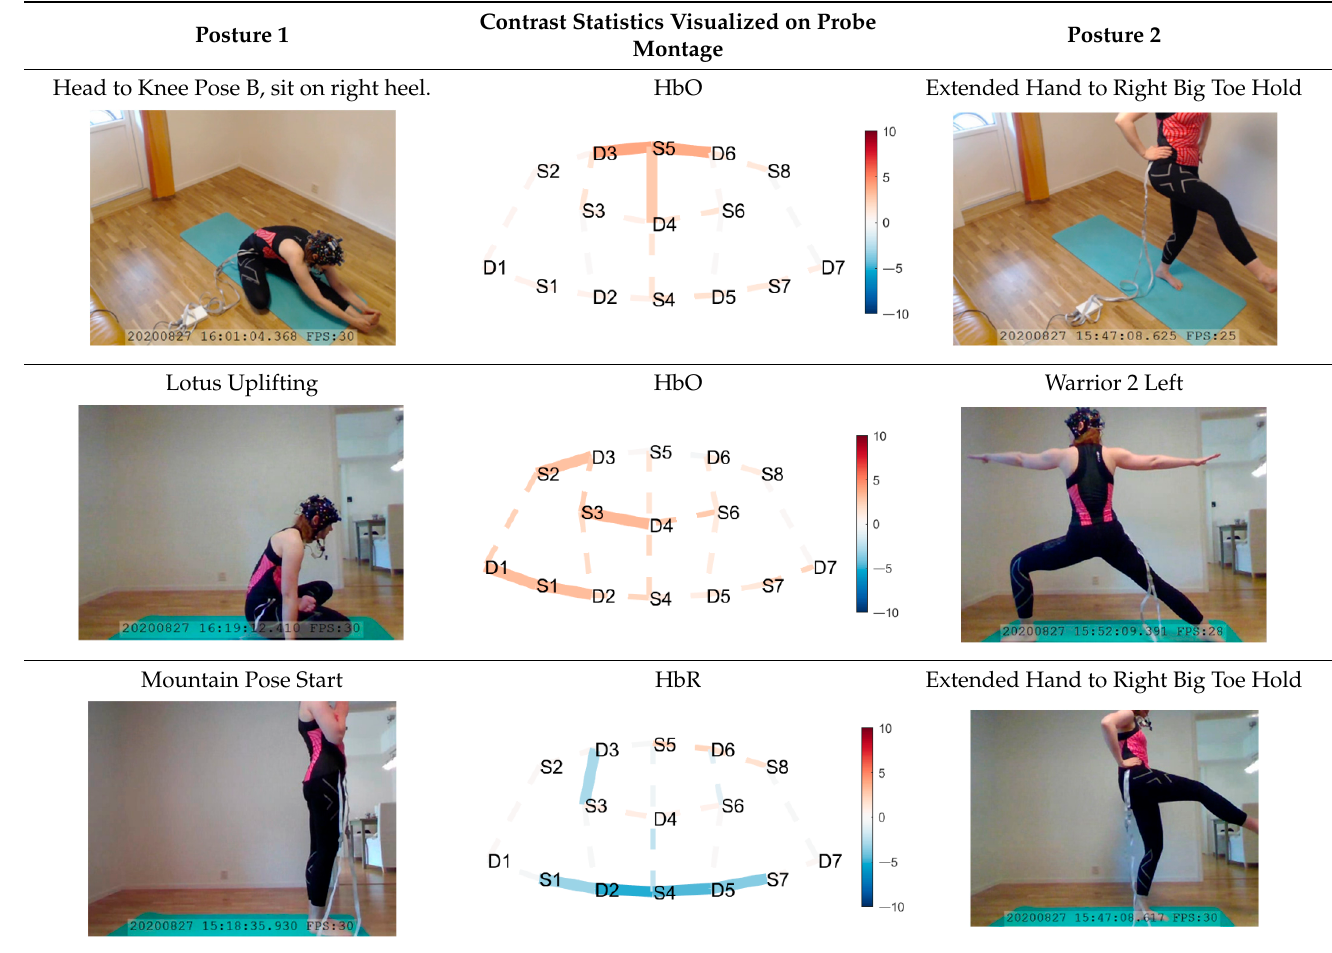
Lotus Uplifting Lotus Uplifting Lotus